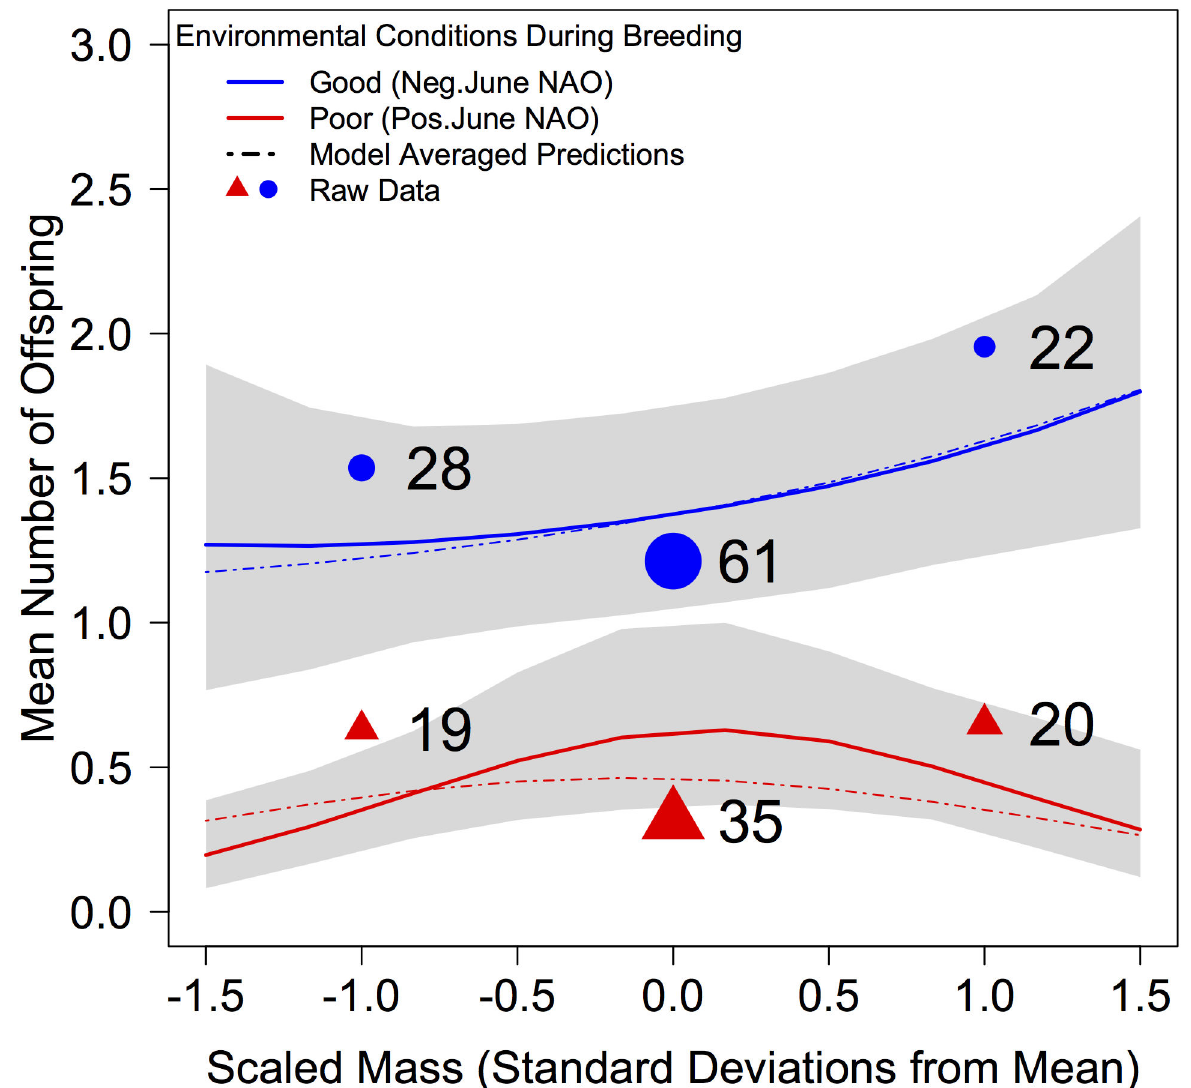
Figure 1. Graph illustrating how the strength of mass-dependent carry-over effects is modulated by the environmental conditions during breeding. In years with positive June NAO (red line), representative of poor weather conditions during breeding, higher body mass does not yield an increase in reproductive success. Conversely, when breeding conditions are favourable (Negative June NAO, blue line), individuals with greater body mass return the following year with more offspring. The x axis represents body mass (as Scaled Mass Index) expressed in units of standard deviations from the mean, where ‘0’ represents an individual of average mass in the sample. Shaded areas span the 95% credible intervals for the fitted means. Points are raw data means for years with positive June NAO (triangles) and negative June NAO (circles), averaged over 1 SD bins of body mass and plotted at the midpoint of that bin. Point size is proportional to sample size per bin. Sample size per bin is displayed next to each point. Predictions for both good and poor environmental conditions are for ‘average' conditions in each scenario, being the mean of years with negative NAO residuals for ‘good’ years and mean positive residuals for ‘bad’ years. Note that as the data predict over values within 1.5 SD of mean body mass, some data at the tails of the distribution for body mass are excluded from the plot. doi: 10.1371/journal.pone.0077783.g001 corrected for body size and seasonal trajectory. We detected a This correlation represents a carry-over effect of mass significant, positive posterior correlation between mass and sequestered on the Icelandic staging grounds prior to migration number of offspring produced, once controlling for body size to breed, in addition to the significant effect of June NAO that and seasonal trajectory within a singular modelling framework. was also recovered by modelling number of offspring as a